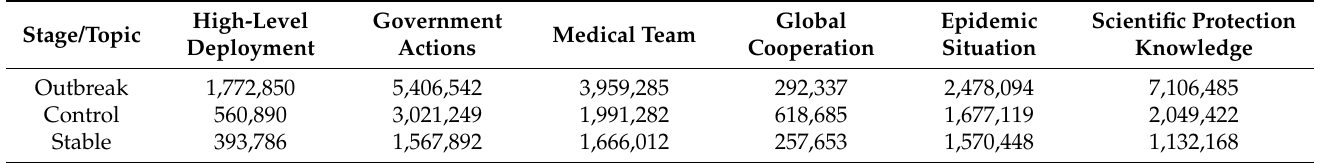
Table 6. Public attention (reads) on different topics of the government at different stages of